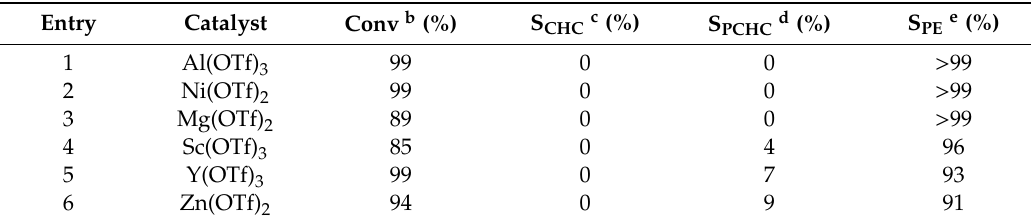
Table 1. Catalytic studies performed with metal triflates complexes a .